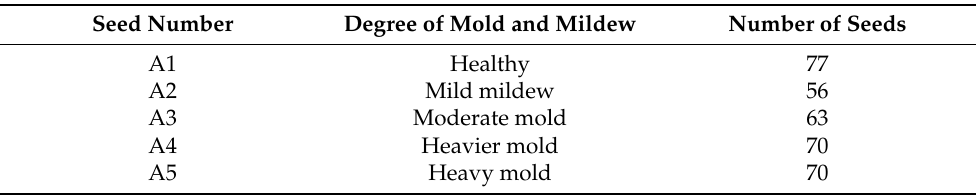
Table 1. Data on different degrees of mildew in maize seeds.